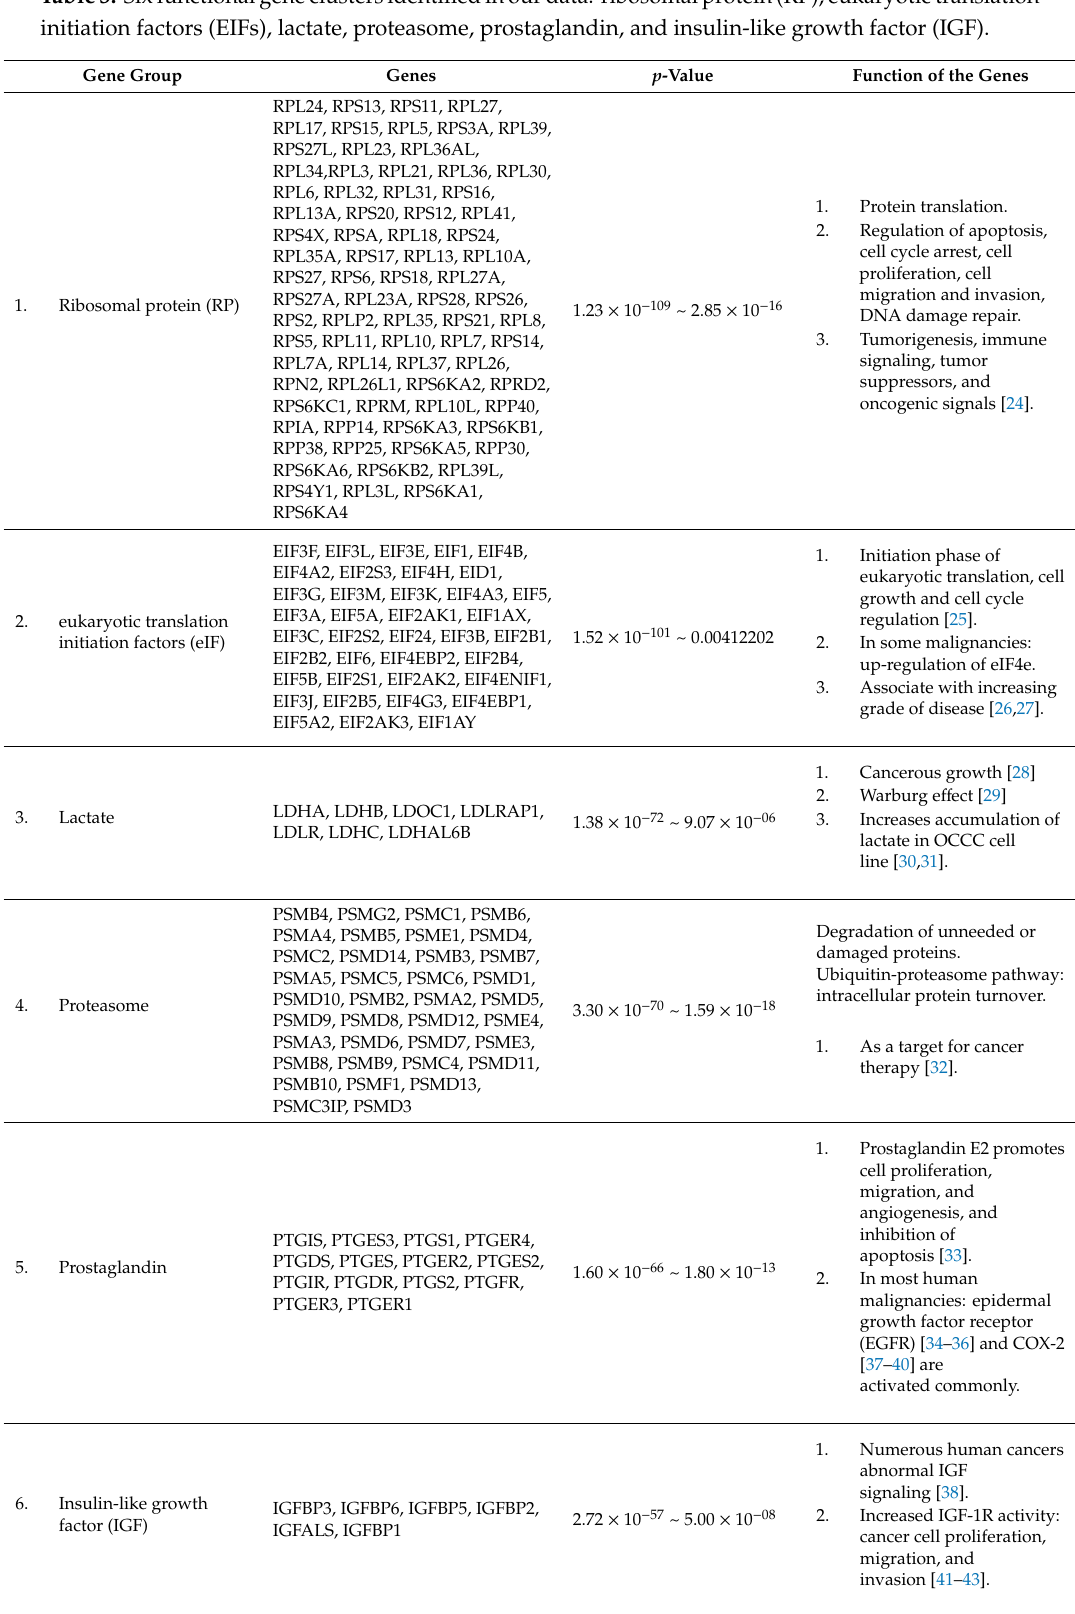
Table 3. Six functional gene clusters identified in our data: ribosomal protein (RP), eukaryotic translation initiation factors (EIFs), lactate, proteasome, prostaglandin, and insulin-like growth factor (IGF). Gene Group Genes p